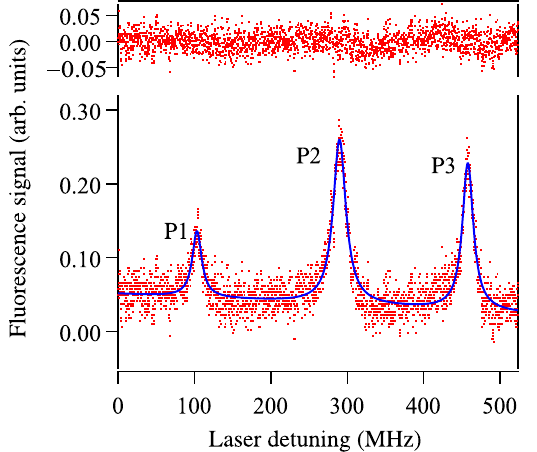
Figure 3. Fluorescence signal from the 3S 1/2 → 2P 3/2 spontaneous decay of the upper state. P1 corresponds to the F = 2 level; P2 corresponds to the F = 1 level; and P3 corresponds to the F = 1 level again but shifted by the AOM frequency. The solid line is a Lorentzian fit to the 3 peaks with the fit residuals shown on top.